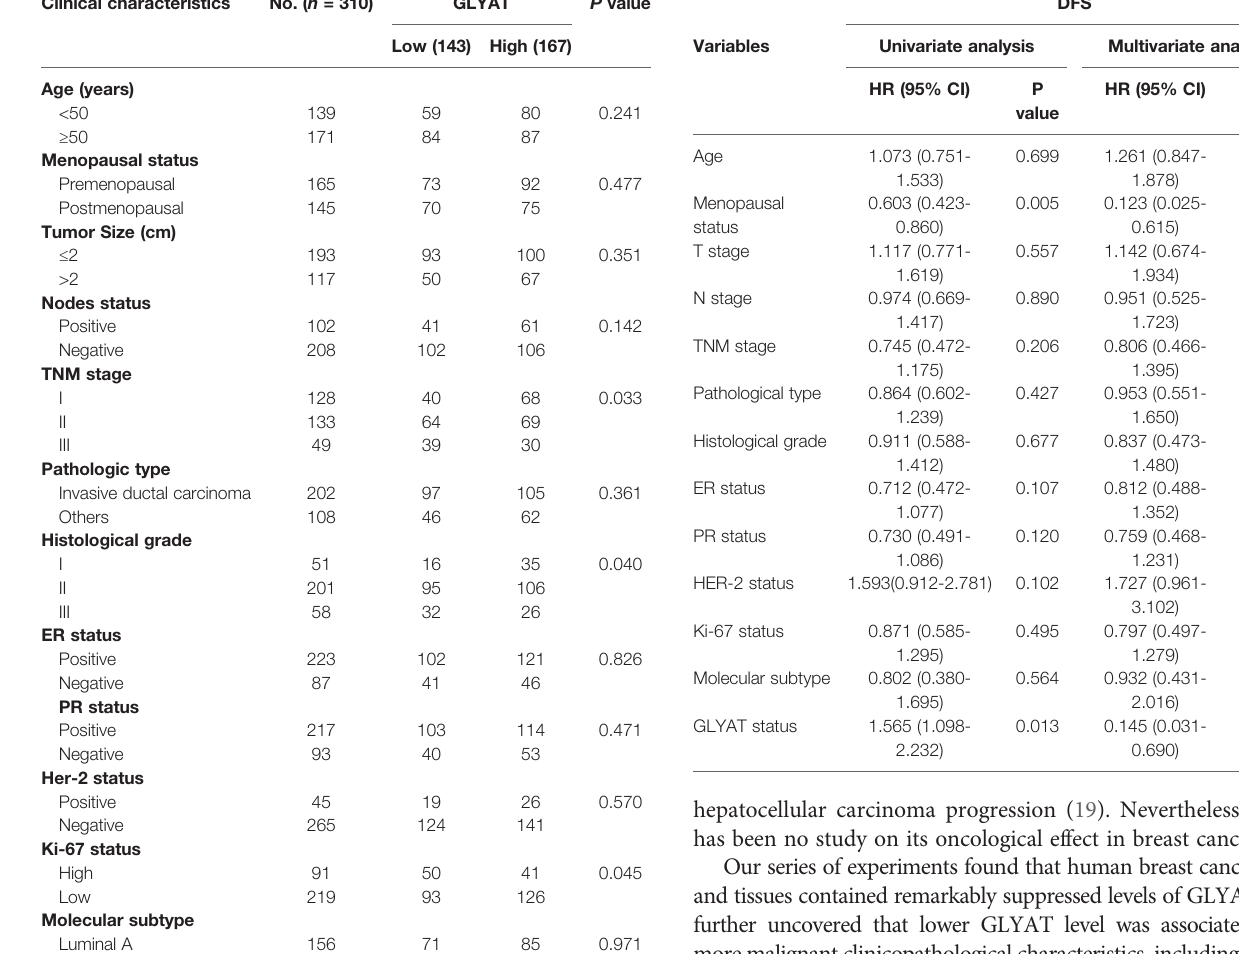
TABLE 1 | Correlation between GLYAT expression level and clinicopathological features in patients with breast cancer. Clinical characteristics